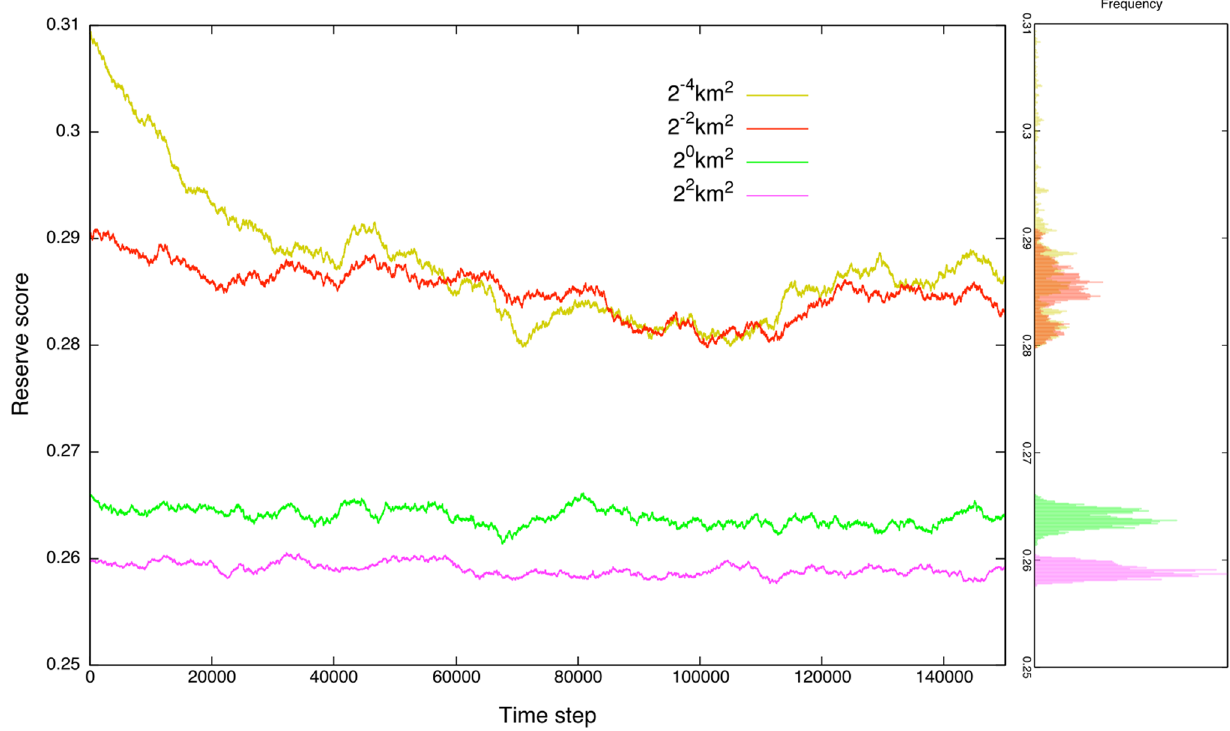
Fig. 4 Example of the effect of the data resolution conversion on the conservation efficacy (presented by reserve score) of spatial planning over time where different colors represent the different data resolutions being used (2 − 4 , 2 − 2 , 2 0 , or 2 2 km 2 ). The reserve score is defined in the range between 0 and 1, where the lowest and highest scores are realized when no individuals are protected and all individuals are protected, respectively. In each simulation, an optimal reserve selection was made at the beginning of the simulation (at t = 0) that occupies 20% of the concerned region with the area 2 6 km 2 . We measure the persistence of conservation efficacy using the coefficient of variation (CV; Takashina 2021) of the reserve score over 1.5 × 10 5 time steps. The CV of each optimal selection is 0.02116, 0.00833, 0.00309, and 0.00231 for the data resolution being used 2 − 4 , 2 − 2 , 2 0 , and 2 2 km 2 , respectively, demonstrating that using a coarser data